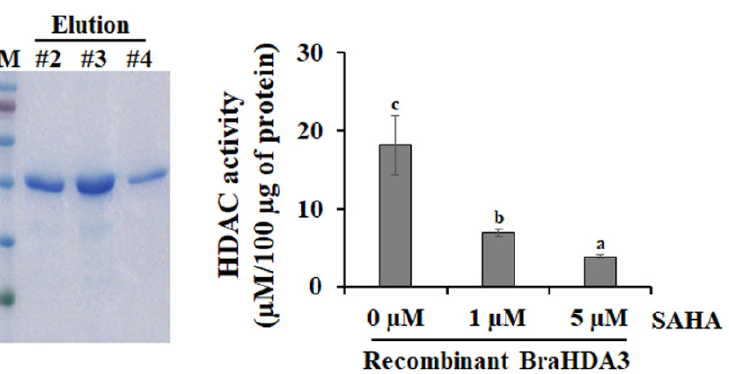
Figure 3. HDAC activity of recombinant BraHDA3. SDS-PAGE exhibited the purified recombinant BraHDA3 proteins. BraHDA3 enzyme activity was analyzed using HDAC Activity Colorimetric Assay Kit. Different letters indicate statistically significant differences ( p < 0.05).